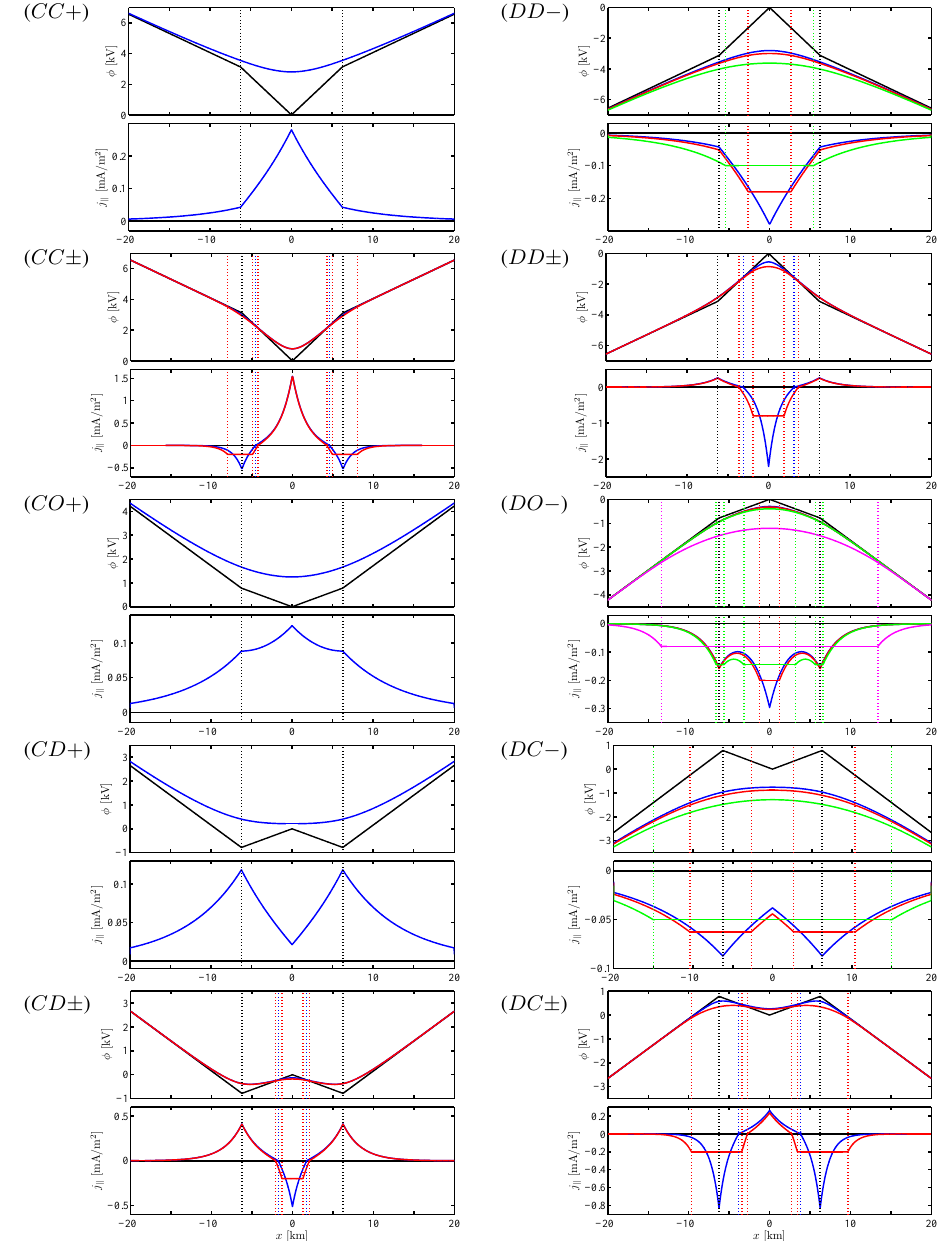
Fig. 5. Solution classes for nested electric fields. Each panel gives the magnetospheric and ionospheric poten- tial ˆ φ (black) and φ (various colors) and the field-aligned current j k (various colors), assuming Σ P = 5 S. Left column, converging outer field (cid:15) out = 250mV/m: ( CC + ) Strong converging inner field (cid:15) in = 500mV/m, K + = 0 . 1mA/kVm 2 . ( CC ± ) Same inner field, K + = 2mA/kVm 2 , K − = 4mA/kVm 2 , without (blue, j ∗ − = −∞ ) or with return current limit (red, j ∗ − = − 0 . 2mA/m 2 ). ( CO + ) Weak converging inner field (cid:15) in = 125mV/m, K + = 0 . 1mA/kVm 2 . ( CD + ) Diverging inner field (cid:15) in = − 125mV/m, K + = 0 . 1mA/kVm 2 . ( CD ± ) Same inner field, K + = 1mA/kVm 2 , K − = 4mA/kVm 2 , with j ∗ − =−∞ or − 0 . 2mA/m 2 (blue, red). Right column, diverging outer field (cid:15) out =− 250mV/m: ( DD − ) Strong diverging inner field (cid:15) in = − 500mV/m, K − = 0 . 1mA/kVm 2 , with j ∗ − = −∞ , − 0 . 18, or − 0 . 1mA/m 2 (blue, red, green). ( DD ± ) Same inner field, K + = 1mA/kVm 2 , K − = 4mA/kVm 2 , with j ∗ − =−∞ or − 0 . 8mA/m 2 (blue, red). ( DO − ) Weak diverging inner field (cid:15) in =− 125mV/m, K − = 1mA/kVm 2 , with j ∗ − =−∞ , − 0 . 2, − 0 . 145, or − 0 . 08mA/m 2 (blue, red, green, magenta). ( DC − ) Converg- ing inner field (cid:15) in = 125mV/m, K − = 0 . 05mA/kVm 2 , with j ∗ − = −∞ , − 0 . 0625, or − 0 . 05mA/m 2 (blue, red, green). ( DC ± ) Same inner field, K + = 1mA/kVm 2 , K − = 4mA/kVm 2 , with j ∗ − =−∞ or − 0 . 2mA/m 2 (blue,